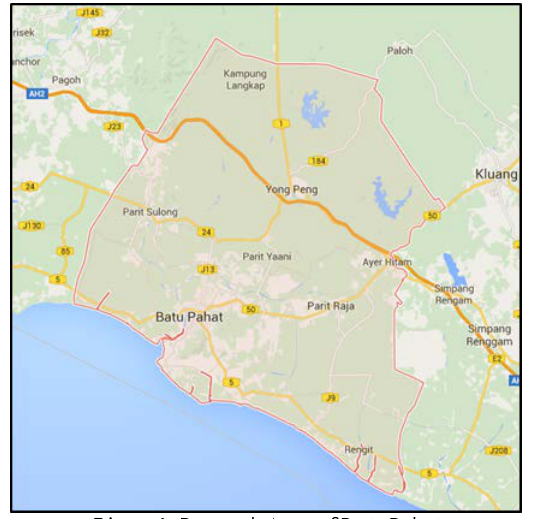
Figure 1. Research Area of Batu